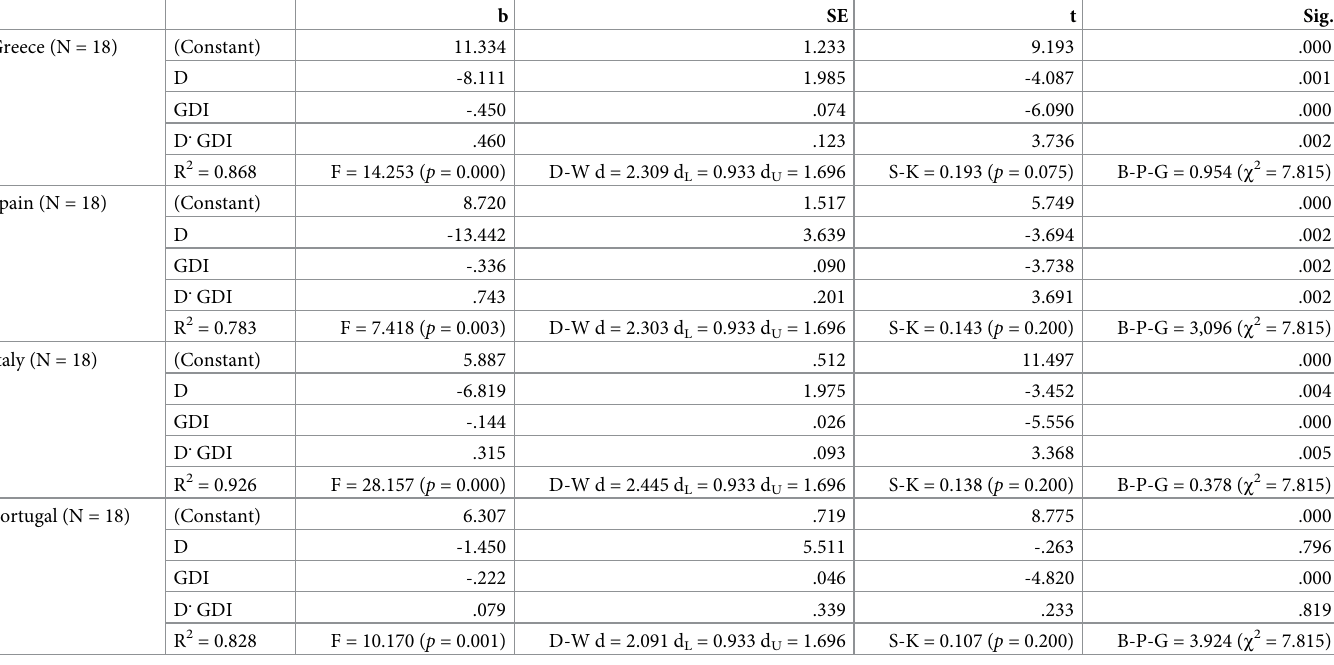
Table 1. Regression results by country: Explanatory variable is Gross Disposable Income (GDI) per capita